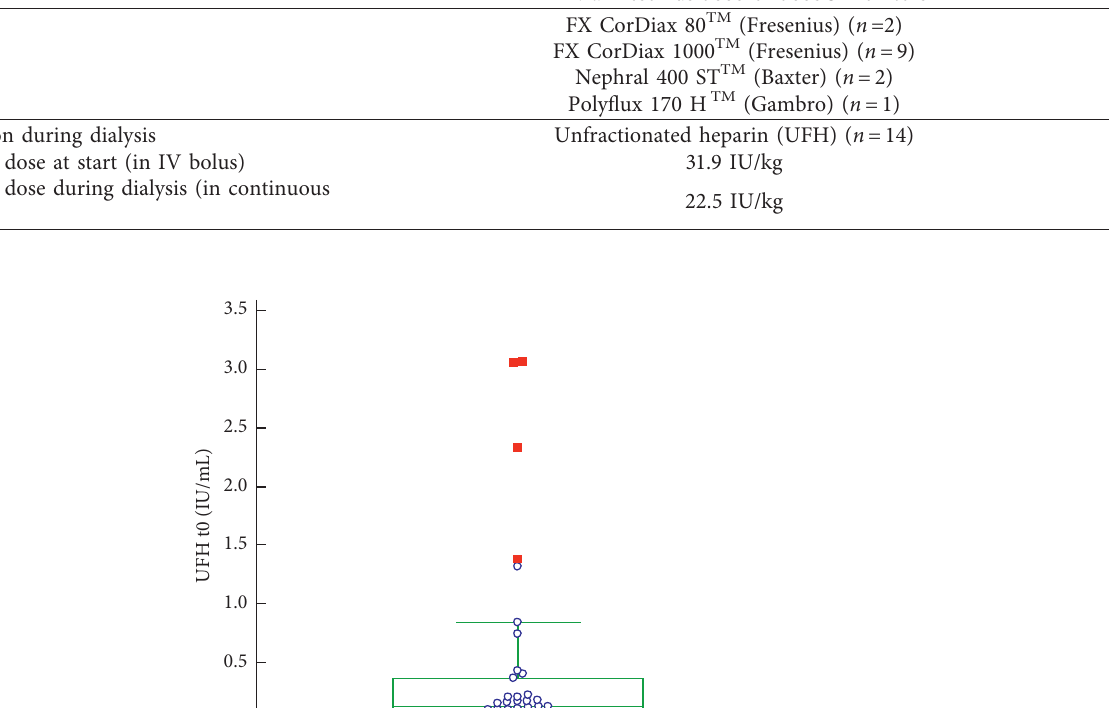
Table 2: Median UFH concentration, POCT INR, and plasma INR at t